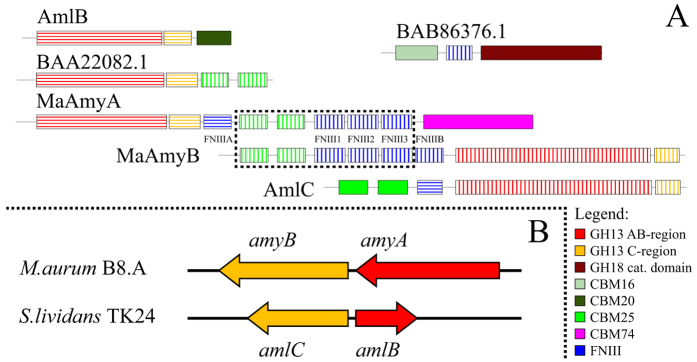
(A) Protein domain organization of MaAmyA and MaAmyB and 4 related proteins. All proteins are shown with the N-terminus on the left hand side. The dotted line box indicates a stretch of domains that is highly similar between MaAmyA and MaAmyB (>99% identity), suggesting a relatively recent duplication event. Equal fill patterns indicate domains with high similarity. Solid filled domains do not have similarity to any other domain shown. AmlB (CAB06622.1) and BAA22082.1 are included as representatives of GH13_32 with high similarity to MaAmyA. AmlC (CAB06816.1) is included as a representative of GH13_42 with high similarity to MaAmyB. BAB86376.1 is included as a representative of a group of chitinases containing FNIII domains with high similarity to the 3 C-terminal FNIII domains of MaAmyA and all FNIII domains of MaAmyB. CBM74 is a novel CBM domain15. (B) Schematic representation showing the orientations of the genes encoding the M. aurum B8.A (MaAmyA, MaAmyB) and S. lividans TK24 (AmlB, AmlC) α-amylases.